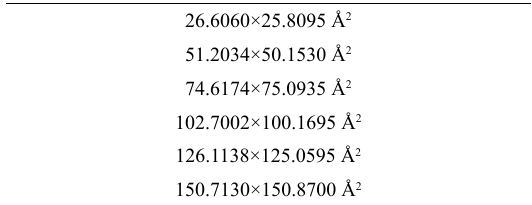
Table 3: Dimensions of selected nanosheets for investigation the bulk